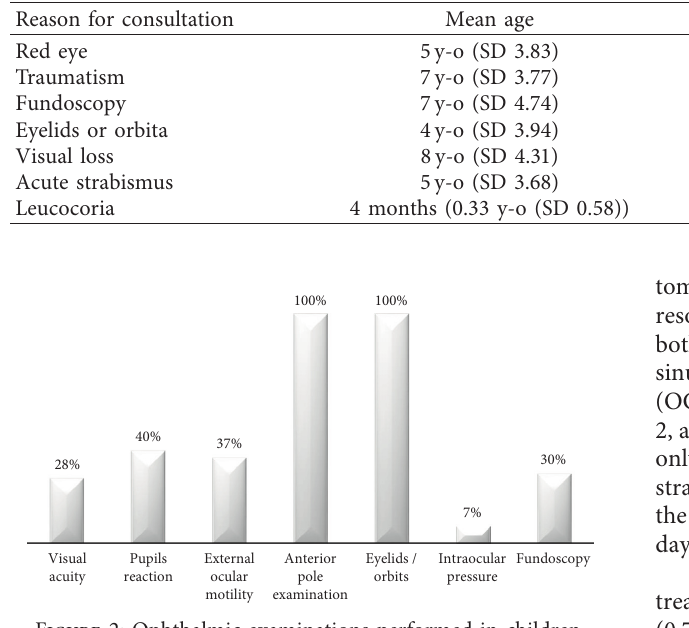
Table 1: Age, sex, and referral source for each reason for consultation.